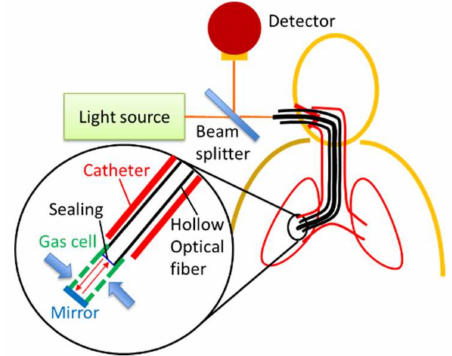
Figure 1. Schematic of proposed fiber-optic probe system for localized gas analysis in a respiratory